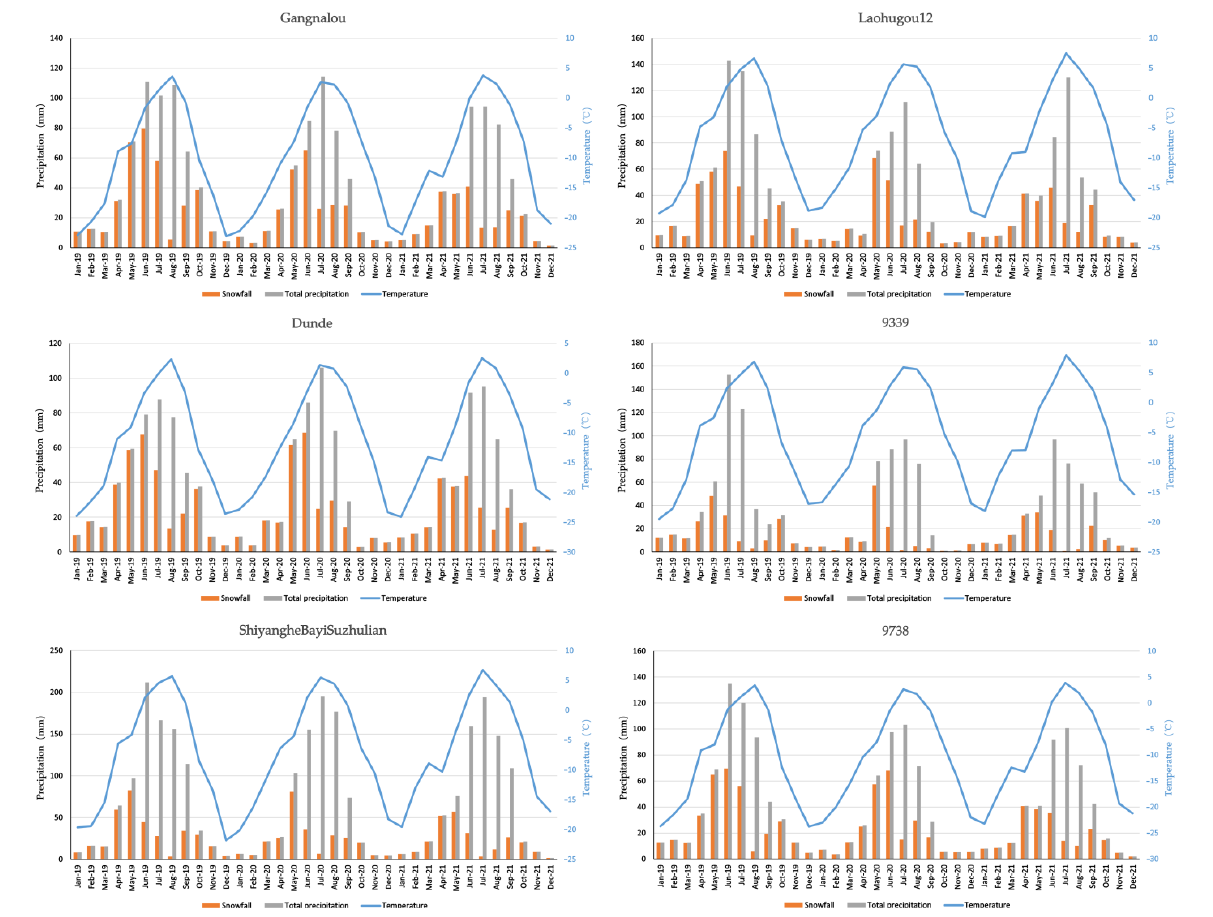
Figure 12. Monthly average temperature, monthly average total precipitation, and monthly average snowfall (mm of water equivalent) in six glacial regions from 2019 to 2021.